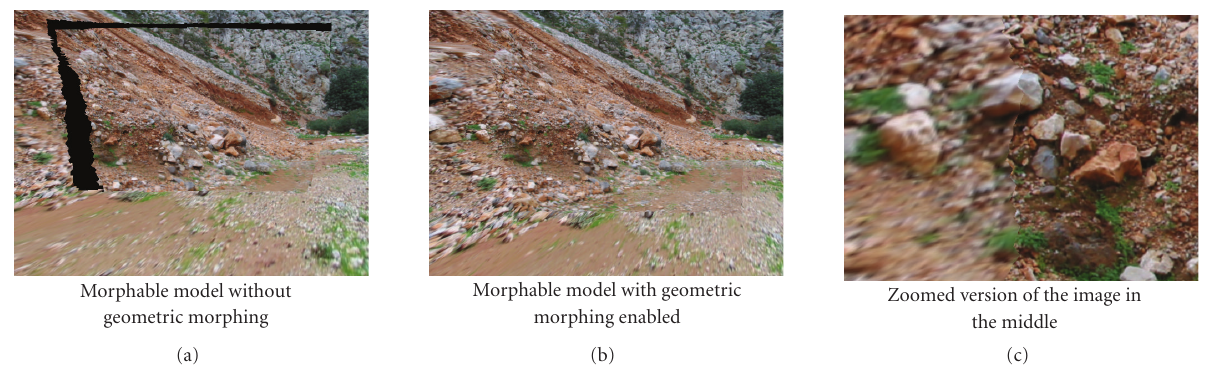
Figure 7: We show rendered views of a morphable 3D-model during the transition from one key-position (corresponding to image I k in Figure 4) to another key-position (corresponding to image I k +1 in Figure 4). On (a) we show the result produced when no geometric morphing is APPLIED to points in Ψ (notice the resulting discontinuity, i.e., hole). On (b) we render the same view, but this time we also apply geometric morphing to points in Ψ (no discontinuities/holes exist in this case). A zoomed version of this view is also shown (c). Although, as mentioned, there is no geometric discontinuity, yet there is a di ff erence in texture resolution between the left part of the image (points in Ψ ) and the right part (points in Ψ ), since only points of the latter part are morphed